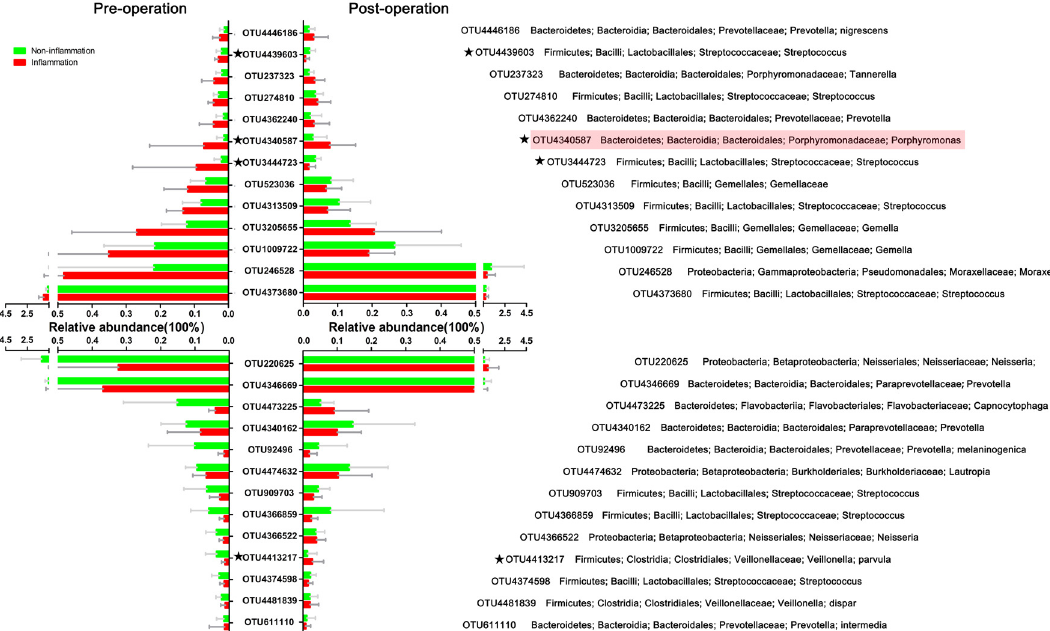
Fig 2. OTUs differing between the non-inflammation and inflammation groups before and after the operation. In total, 26 OTUs with relative abundances higher than 0.01% exhibited significant differences in mean relative abundances between the non-inflammation and inflammation groups before the operation (Mann-Whitney test, P < 0.05). Bars indicate means ± SEM relative abundances. The upper part of the diagram shows that the levels of 13 pre-operative OTUs were higher in the inflammation group, and the lower part shows that another 13 OTUs were lower. The relative abundance of four OTUs marked with the stars ( $ ) were significantly different between the inflammation and non-inflammation groups both pre- and post-operation.A higher proportion of OTU4340587, corresponding to Porphyromonas sp . (with the pink shadow), was found in inflammation subjects than in non-inflammation subjects both pre- and